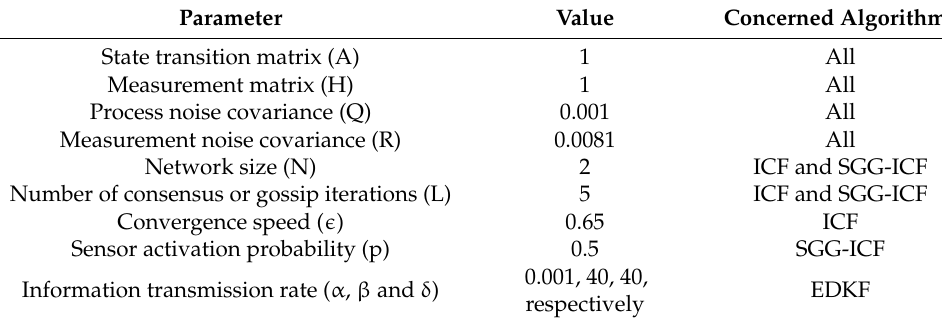
Table 2. Values assigned to DKF